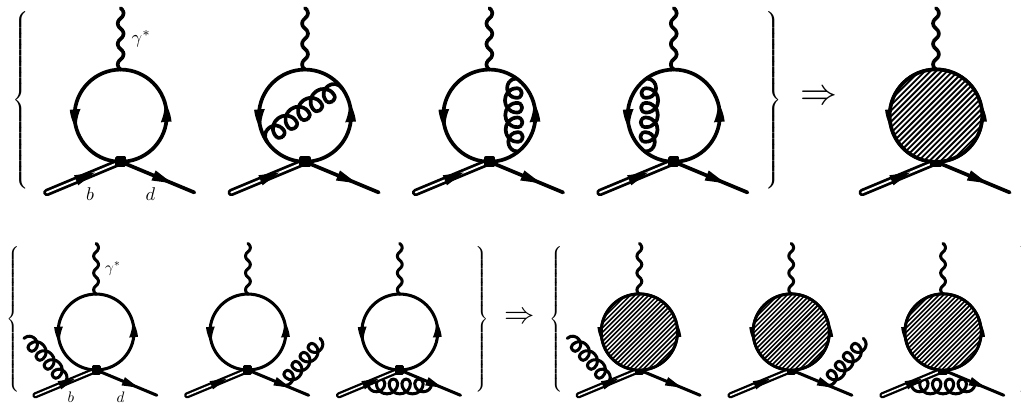
Figure 1 . The one- and two-loop factorizable quark loop amplitudes and the all-orders factorizable amplitude that replaces them. Nonfactorizable contributions, where the gluon connects the quark- loop and the heavy-light current or radiates o(cid:11) the quark-loop, are kept perturbative and are not replaced by the KS function.